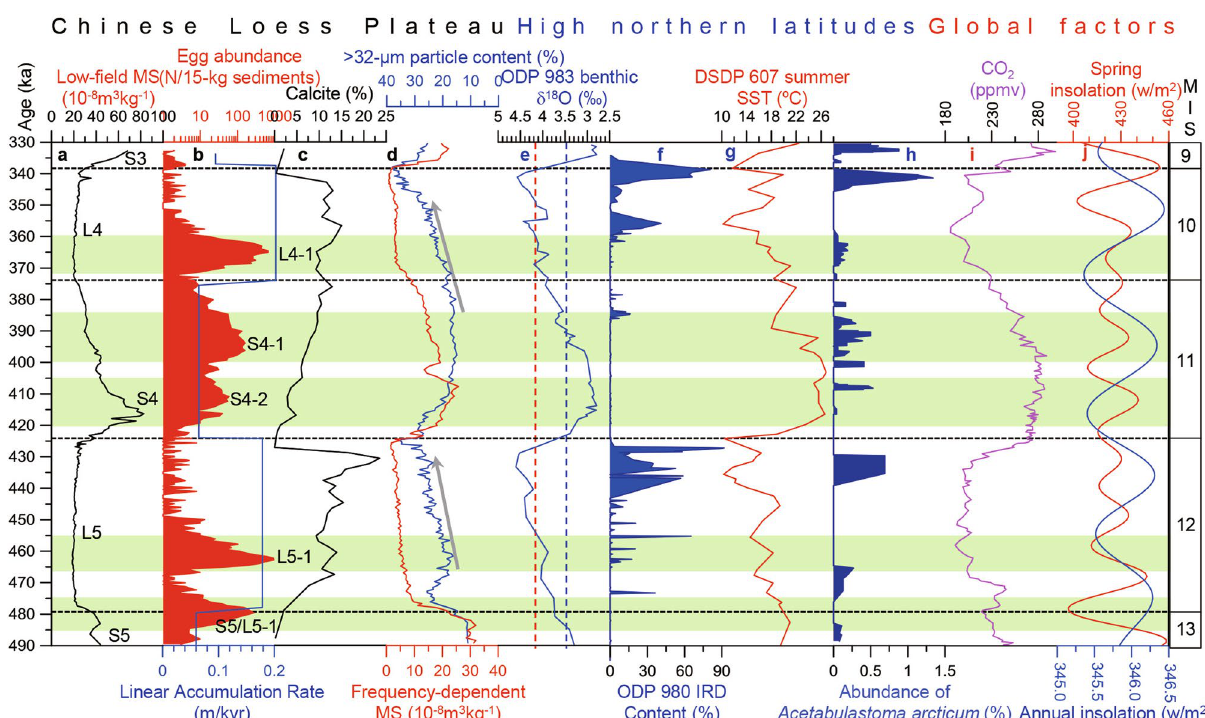
Figure 4. Seasonal cooling events in the Chinese Loess Plateau and their comparison with other records from the Chinese Loess Plateau ( a–d ), high northern latitudes ( e–h ) and global factors ( i,j ) during Marine Isotope Stages (MIS) 12–10. ( a,b ) Magnetic susceptibility (MS) record, seasonal cooling events (red) (L4-1, S4-1, S4-2, L5-1 and S5/L5-1, from top to bottom), as documented by egg-abundance peaks, and linear accumulation rate (blue) from the Huining section, respectively. The units of loess (L5 and L4) and paleosol (entire S4, and parts of S5 and S3) are labeled on the low-field MS record. ( c ) Calcite content in the Luochuan section 14 . ( d ) The content of coarse grain size (> 32 μm) (blue) and frequency-dependent MS (red) in the Luochuan section 5 . ( e ) Benthic δ 18 O record from Ocean Drilling Program (ODP) Site 983 located at 60.4° N, 23.64° W 16 . The red and blue dashed lines indicate the 4.2‰ and 3.5‰ thresholds of benthic δ 18 O values, respectively. ( f ) Ice-rafted debris (IRD) record from ODP Site 980 at 55° N, 15° W in the subpolar North Atlantic 17 . ( g ) Summer sea surface temperature (SST) record from Deep Sea Drilling Project (DSDP) Site 607 at 40° N, 32.97° W 18 . ( h ) Relative abundance of the ostracod Acetabulastoma arcticum which indicates sea ice cover in the Arctic Ocean 20 . ( i ) CO 2 record from the European Program for Ice Coring in Antarctica (EPICA) Dome C ice core 19 . ( j ) Spring (red) and mean annual (blue) insolation at Huining located at the latitude of ~ 36º N 21 . MIS is labeled on the right.